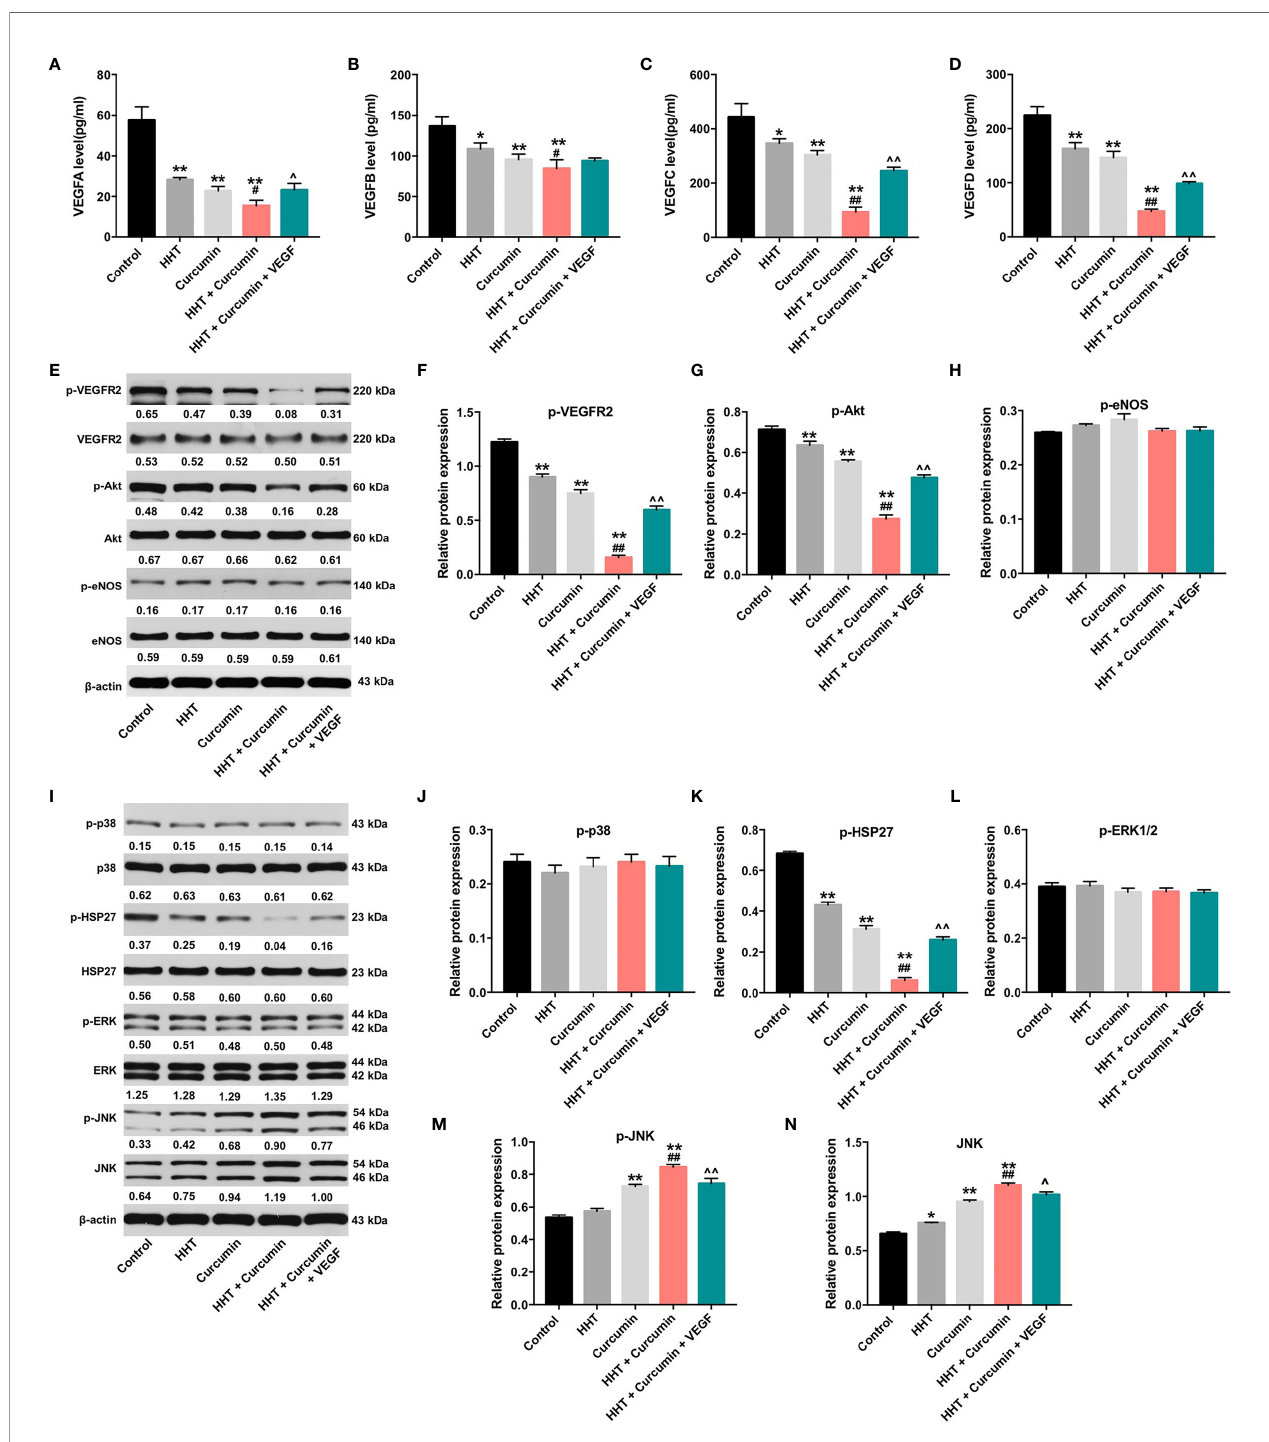
FIGURE 3 | Combination of curcumin with HHT inhibit the growth of lymphoma cells via inhibition of VEGF/VEGFR2 signaling pathway. Raji cells were treated with 5 ng/mL HHT or/and 10 m M curcumin for 72 h or treated with HHT, curcumin and VEGF. The levels of (A) VEGF-A, (B) VEGF-B, (C) VEGF-C, (D) VEGF-D in cell culture supernatant was assessed with ELISA. (E) Expression levels of p-VEGFR2, VEGFR2, p-Akt, Akt, p-eNOS and eNOS in Raji cells were detected with western blotting. (E – H) The relative expressions of p-VEGFR2, p-Akt, and p-eNOS in cells were quanti fi ed via normalization to VEGFR2, Akt and eNOS. (I) Expression levels of p-p38, p38, p-HSP27, HSP27, p-ERK, ERK, p-JNK, JNK in Raji cells were detected with western blotting. (J – N) The relative expressions of p-p38, p-HSP27, p- ERK, p-JNK, JNK in cells were quanti fi ed via normalization to p38, HSP27, ERK, JNK and b -actin. *P < 0.05, **P < 0.01 compared with control group; # P < 0.05, ## P < 0.01 compared with HHT group; ^ P < 0.05, ^^ P < 0.01 compared with HHT + curcumin